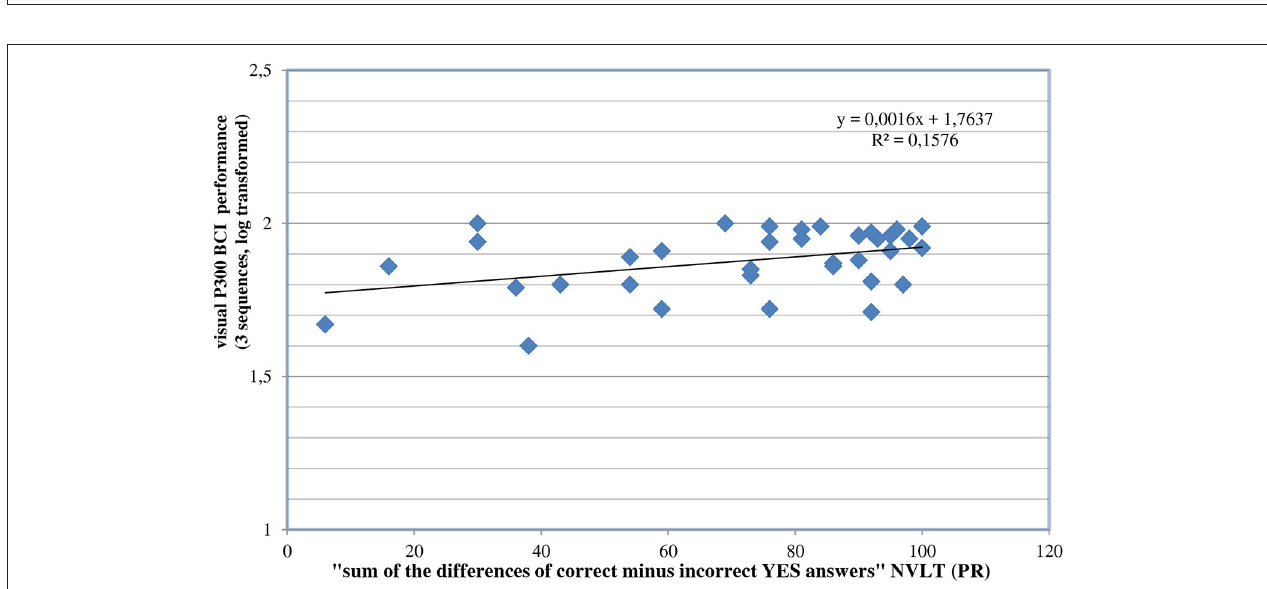
FIGURE 1 | Correlation between emotional stability and the visual P300-BCI offline performance after two outlier values were excluded (PR is the abbriviation for percentile rank).